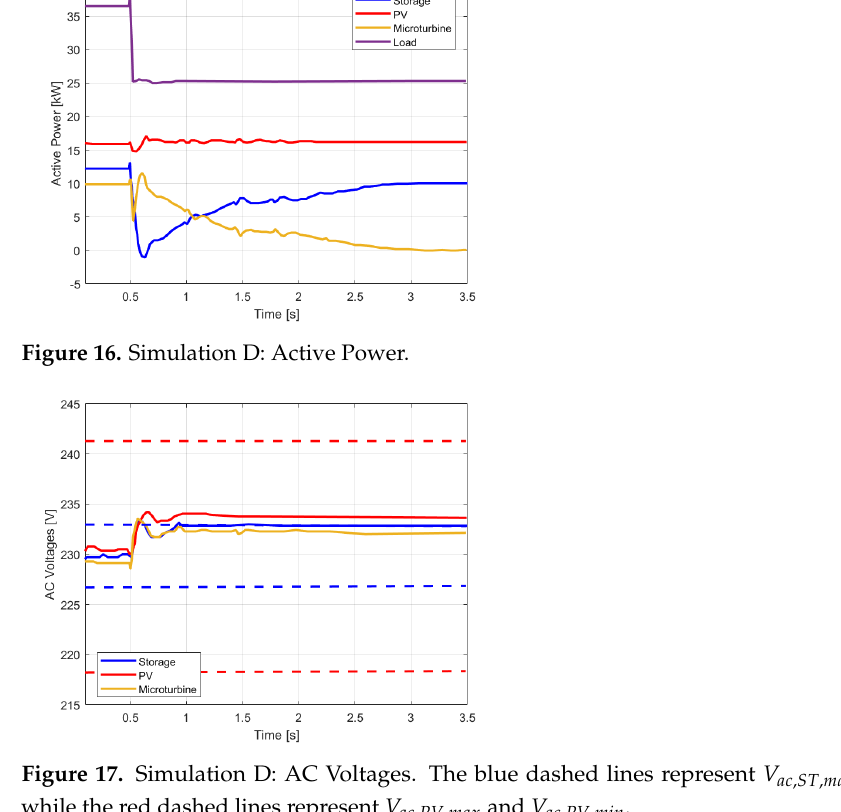
Figure 17. Simulation D: AC Voltages. The blue dashed lines represent V ac , ST , max and V ac , ST , min , while the red dashed lines represent V ac , PV , max and V ac , PV , min .